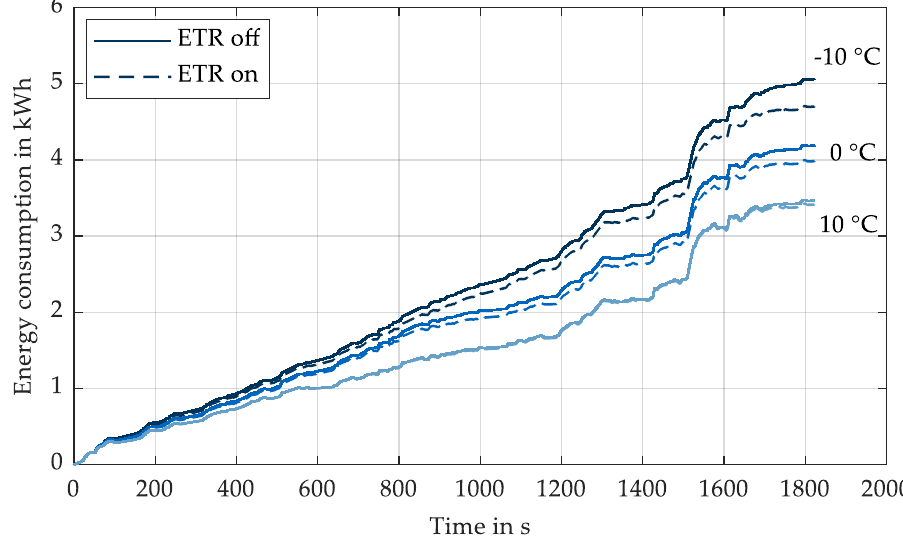
Figure 6. Vehicle energy consumption during one FTM cycle at different temperatures.